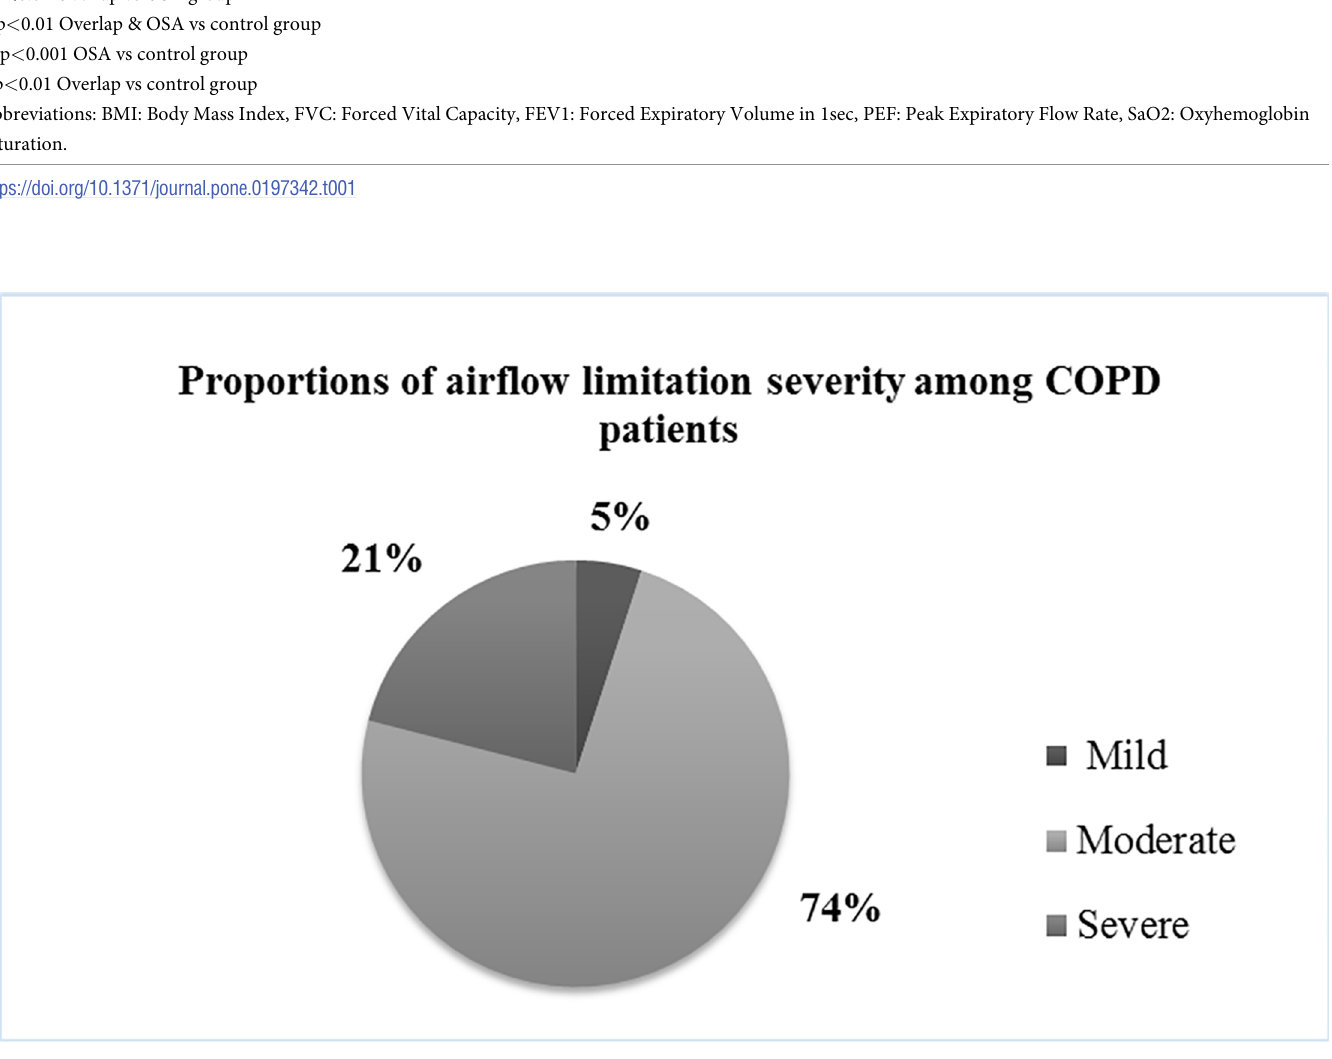
Fig 2. Severity of airflow limitation in COPD